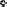
Behavioral analysis mediated by Galanin (GAL) and the NPYY1R agonist in the elevated plus maze. The response induced by GAL on the NPYY1-mediated ethological behaviors is blocked by the GAL 2 receptor (GALR2) antagonist M871. Cumulative behavioral duration of rearings (A), SAP (B), freezing (C) and head-dipping (D) in this test. N = 6–8 animals in each group. Data represents mean ± SEM. Value for GAL+Y1+M871 group on freezing was 0. ∗P < 0.05; ∗∗∗P < 0,001; ≠P < 0.05; ≠≠≠P < 0.001; δP < 0.05; P < 0.05 according to one-way ANOVA followed by Newman–Keuls Multiple Comparison Test. Inter-group comparisons are indicated by the lines above bars. GAL, Galanin 3 nmol; Y1 = NPY Y1 receptors agonist [Leu31-Pro34]NPY 3 nmol; GAL+Y1, Coadministration of GAL and Y1; GAL+Y1+M871, Coadministration of GAL, Y1 and GALR2 antagonist M871 3 nmol.